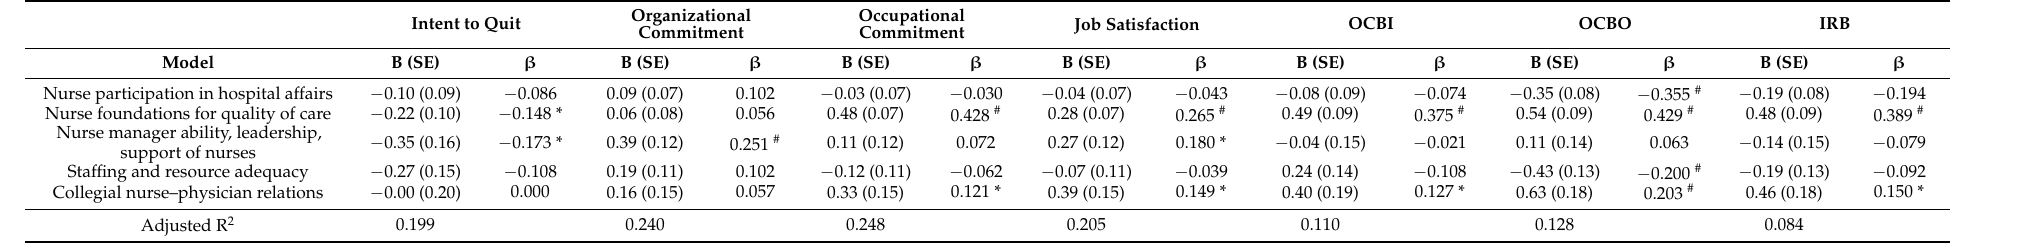
Table A4. Summary of regression analyses using the PES-NWI (Lake, 2002) [17]